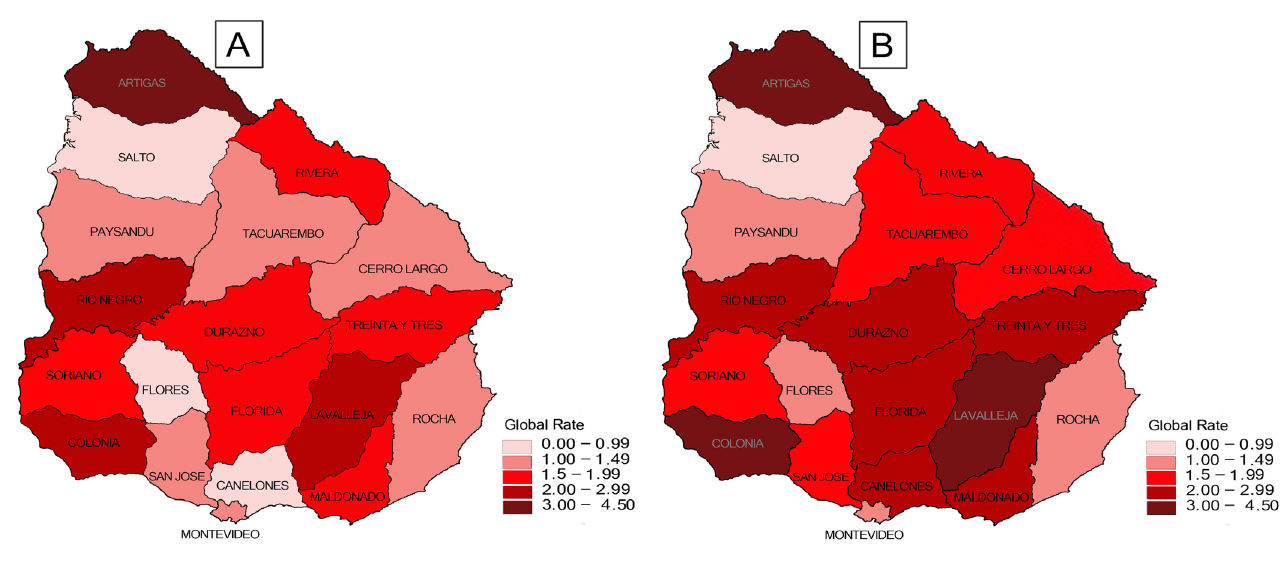
Figure 1. Department distribution of confirmed cases of disorders detected by abnormal screening tests between 2010 and 2014. (A) Department distribution of newborns in accordance with place of birth. (B) Department distribution of newborns in accordance with maternal residence.